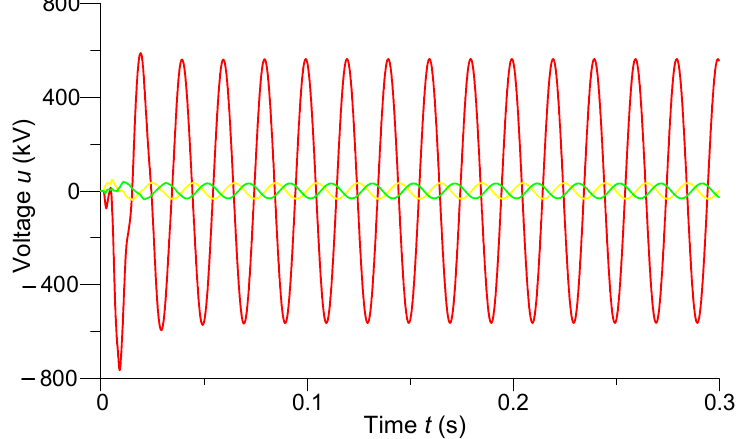
Figure 10. Transient processes of phase voltages on the last discrete node of the line (24 km to the end of the line).